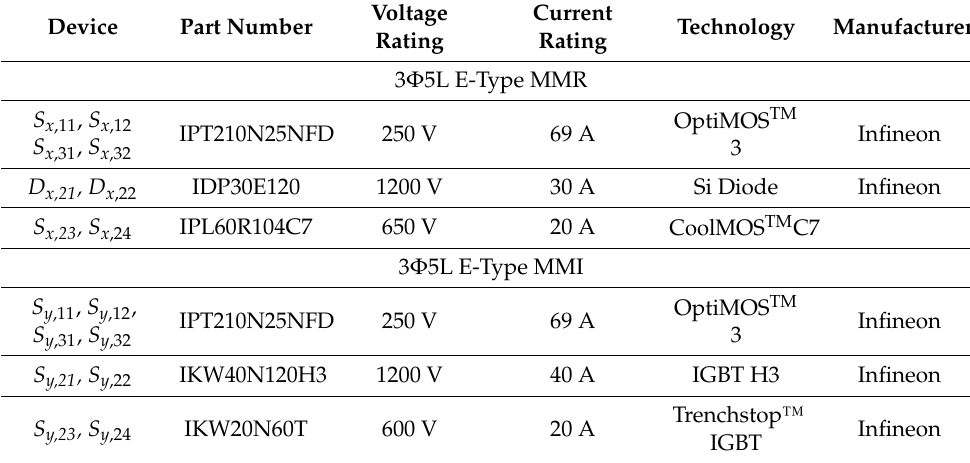
Table 1. Power semiconductors used to build the 3 Φ 5L E-Type MMR and MMI with x ∈ {1 R , 2 R } and y ∈ {1 I , 2 I